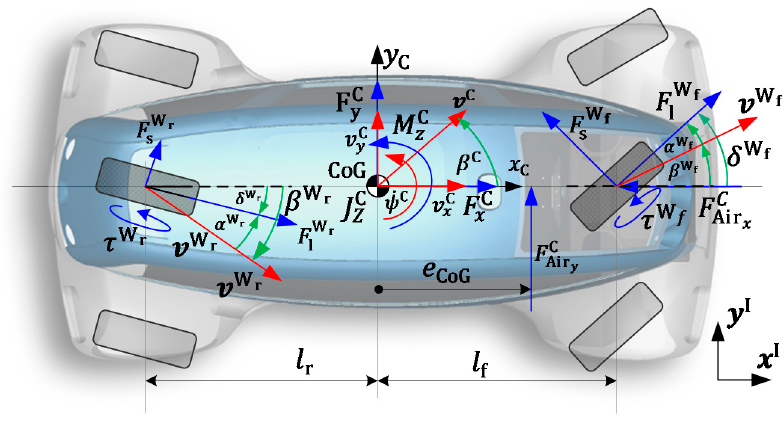
Figure 3. Vehicle dynamics quantities of the extended single track model.